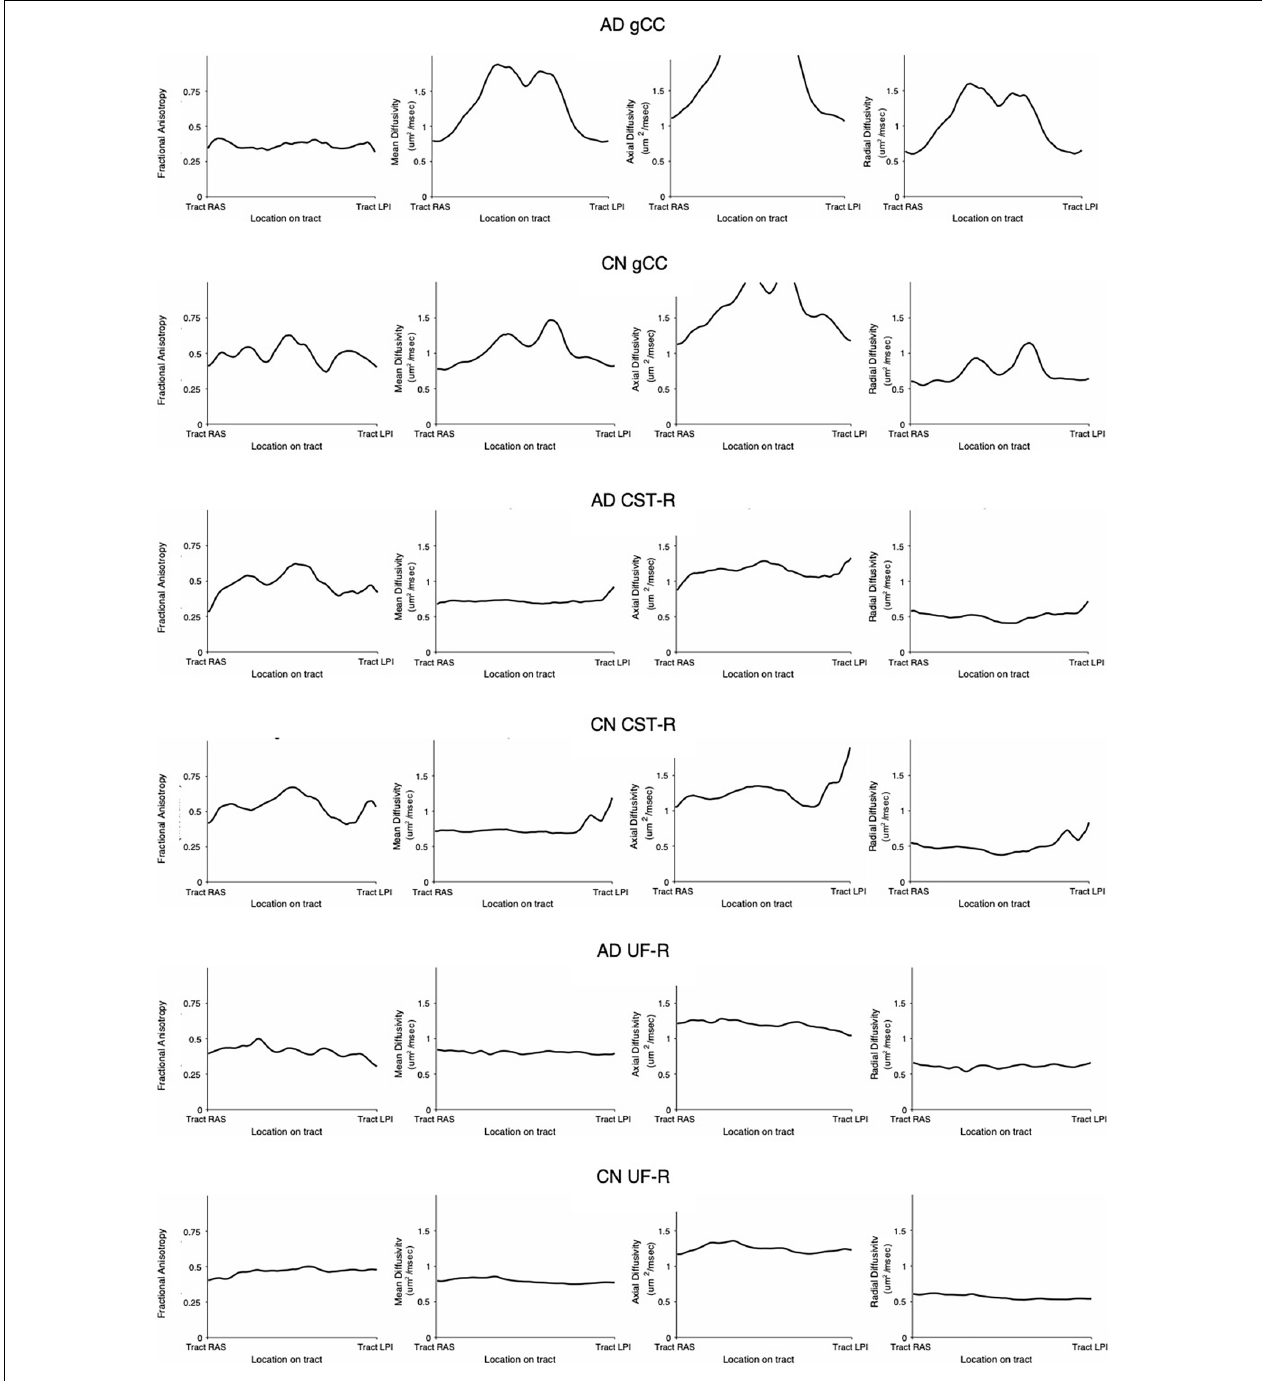
FIGURE 7 | White matter tract profiles demonstrating variability along tracts. AD, Alzheimer’s disease; CN, cognitively normal; gCC, genu of the corpus callosum; CST-R, corticospinal tract (right); UF-R, uncinate fasciculus